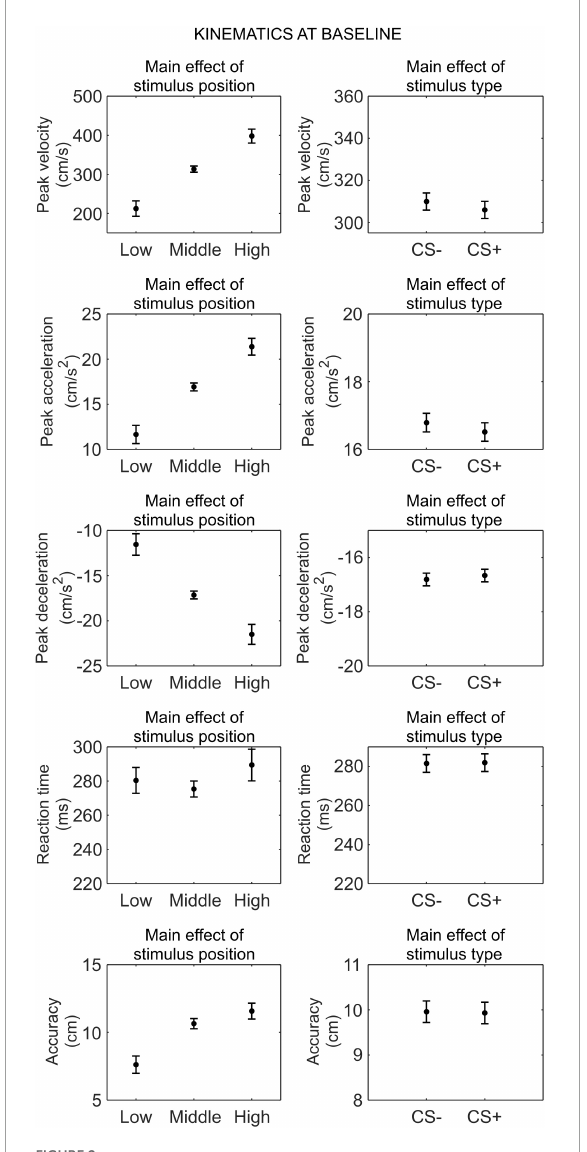
FIGURE2 Kinematics at baseline. Each plot shows the group mean (black dot) and 95% confidence intervals (vertical bars) of the different kinematic parameters as a function of the stimulus position or the stimulus type. 95% CI were corrected for within-subjects designs (Cousineau, 2005).